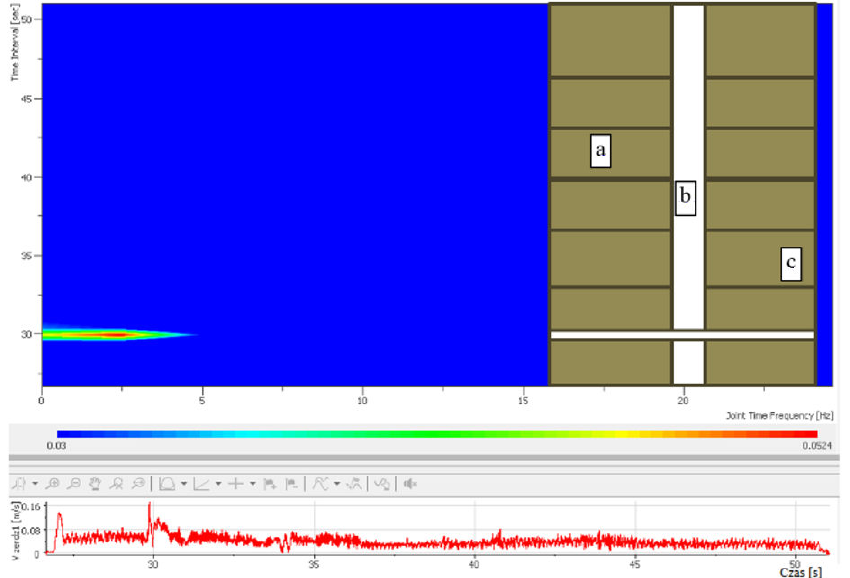
Figure 23. The detected signal on the recorded spectrogram corresponding to the location the critical discontinuity for borehole 4, rod 2—Hanning window, time domain sieve line set to 70, amplitude level display > 0.03; a, rock layer; b, borehole; c,